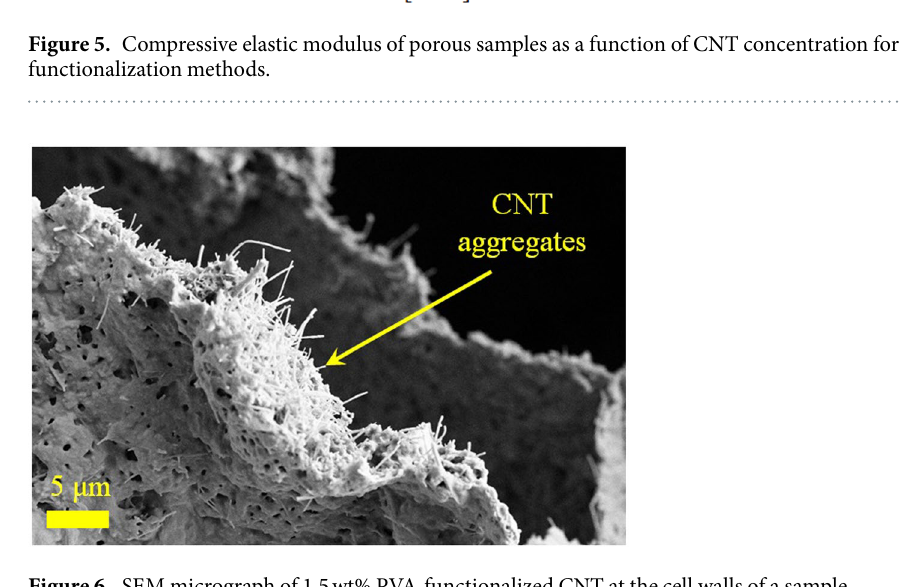
Figure 6. SEM micrograph of 1.5 wt% PVA-functionalized CNT at the cell walls of a